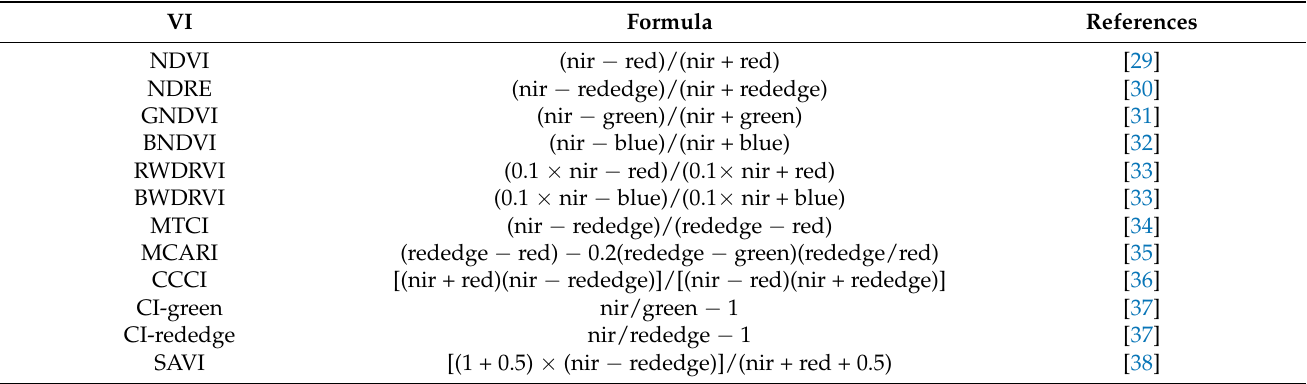
Table 2. Calculated vegetation indices and formulae based on the Micasense Rededge MX